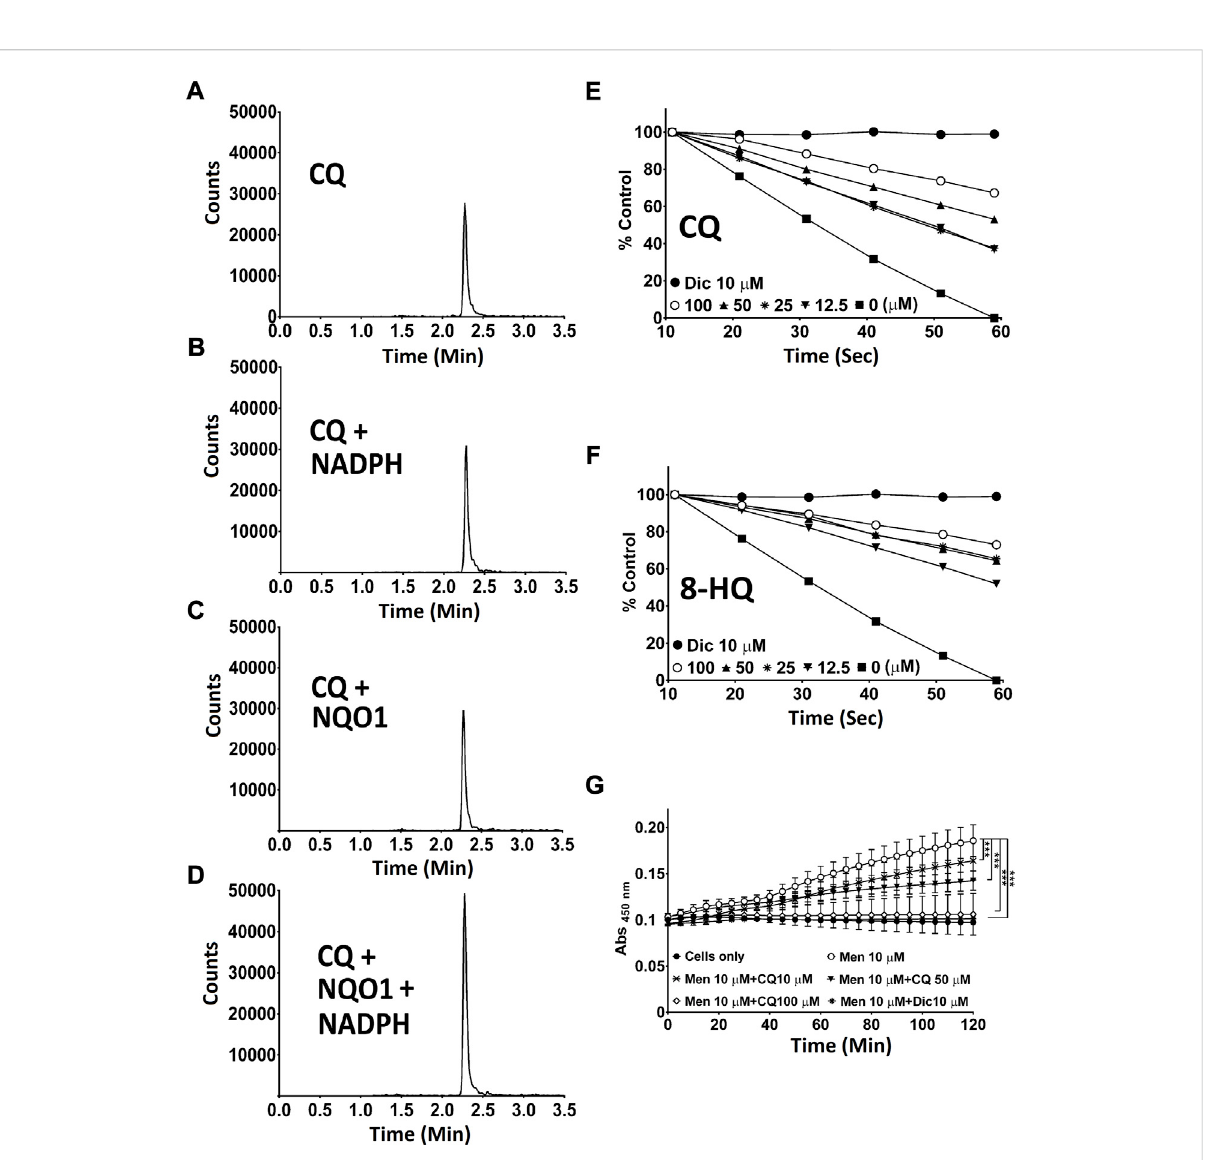
Interaction of CQ and 8-HQ with NQO1. (A-D) Mass spectrometric analysis of CQ. Potential metabolic conversion of CQ in the presence of NQO1 and NADPH was analysed by mass spectrometry. (E,F) Cell-free NQ O 1 activity measurement using recombinant human NQ O 1. NQO1 enzyme activity in the presence of 12.5 – 100 μ M CQ (E) or HQ (F) was determined by measuring the NQO1-dependent linear decrease in DCPIP absorbance at 600 nm. (G) CQ-mediated NQ O 1 inhibition in cells. Cellular NQO1 enzyme activity in the presence of CQ (10 – 100 μ M) was measured using NQO1-mediated WST-1 dye reduction in HepG2 cells. P * < 0.05, p ** < 0.01 and p *** < 0.001 versus control using two-way analysis of variance (ANOVA) followed by Dunnett multiple comparison tests. Error bars = SD. Men: menadione, CQ: clioquinol, 8-HQ: 8- hydroxyquinoline, Dic: